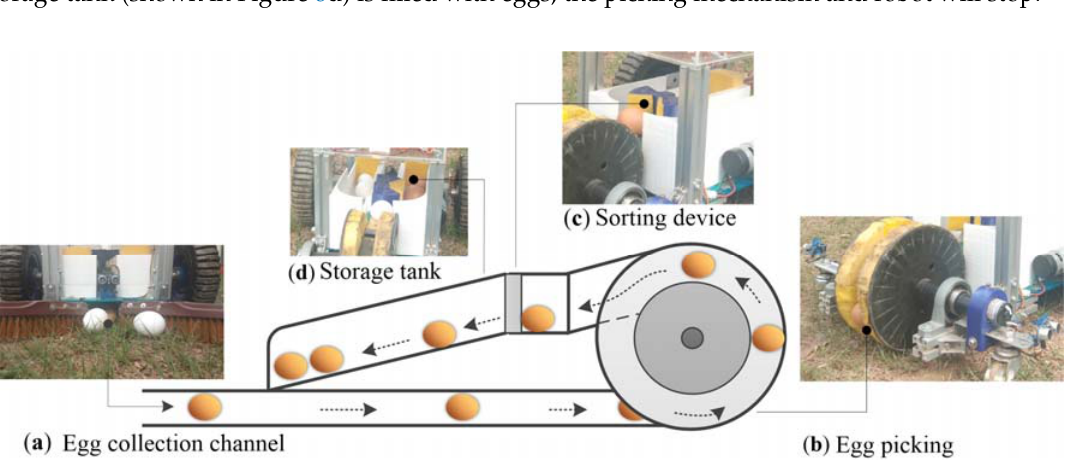
Figure 8. The egg collection process: ( a ) egg collection channel; ( b ) egg-picking; ( c ) sorting device; ( d ) storage tank.